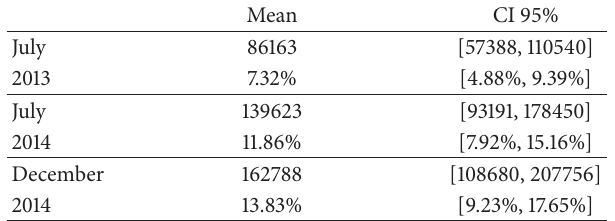
Table 10: Mean and CI 95% of the accumulated infected smart- phones in July 2013, July 2014, and December 2014 in the community of Valencia and the corresponding percentages predicted by the model.